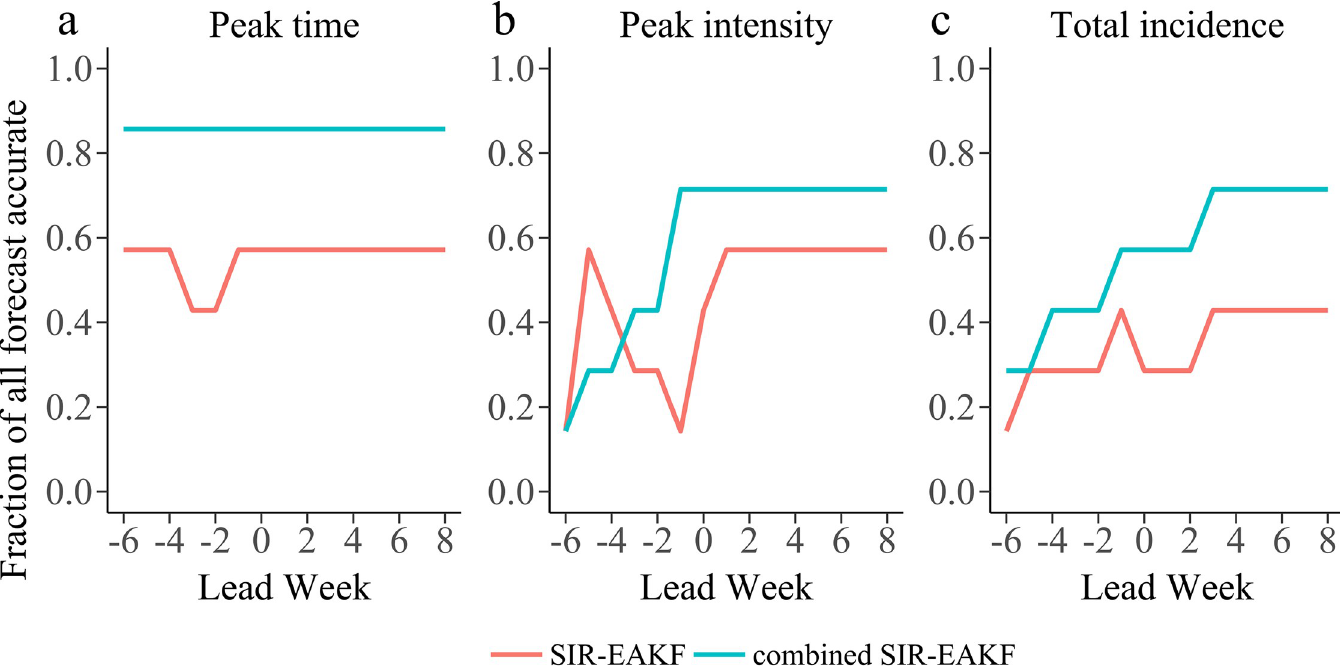
Fig 6. Comparison of the SIR-EAKF and the combined SIR-EAKF system. Historical dengue seasons of 2011–2012 to 2017–2018 were used to compare the prediction accuracy of two models, the SIR-EAKF model (red) and the combined SIR-EAKF model (blue). Finally, the fraction of forecasts accurate as a function of lead week for the targets peak time, peak intensity and total